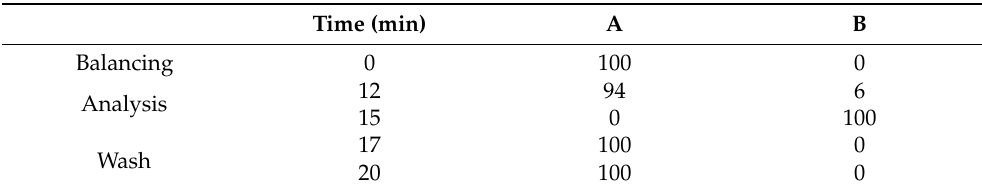
Table 1. Chromatographic gradient. Buffer A was 40 mM sodium acetate and methanol 17% pH 3.9. Buffer B was a 100% methanol. The flow rate was 1